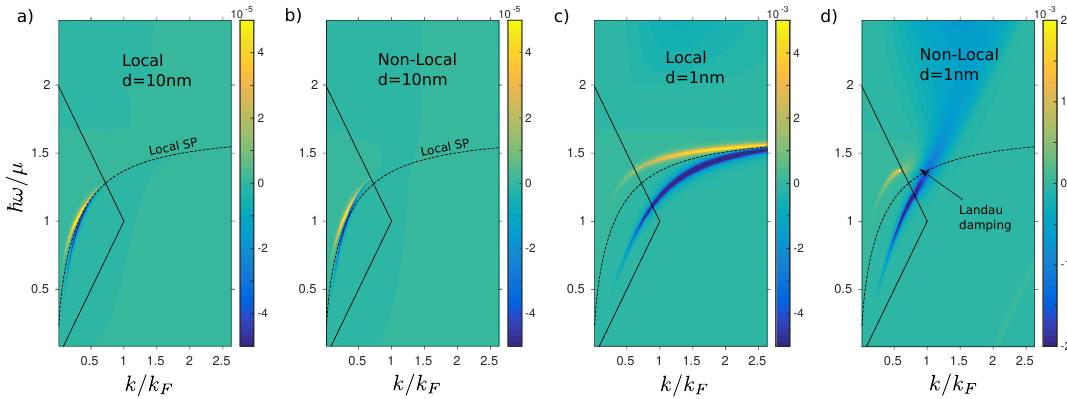
Figure 3. Force per unit area spectrum (in Ns/m 3 ) of two graphene sheets ( µ = 0.5eV, ¯ h Γ = 0.02eV, v F = 10 6 ms − 1 ) separated by ( a , b ) 10 and ( c , d ) 1nm for the ( a , c ) local ( k = 0) and ( b , d ) non-local cases. The axes have been renormalised to k F = µ /¯ hv F and µ respectively. We also plotted as a dashed line, the dispersion relation for uncoupled surface plasmons in the local picture k sp = − 2 ε 0 / χ .